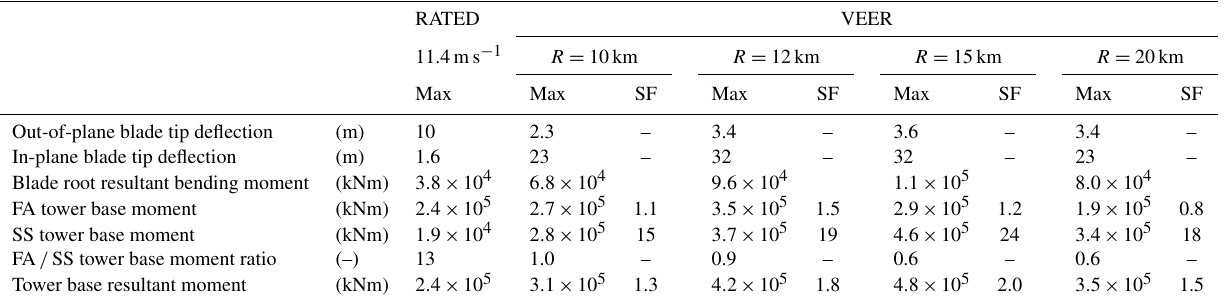
Table 5. Maxima of blade and tower structural response to the VEER case. The scale factor (SF) indicates the magnitude of response relative to RATED. Cells highlighted in gray indicate values that exceed the Eurocode strength basis value for the tower (5 . 4 × 10 5 kNm) or the 18m deflection limit on the blade tip. Numerical values of the scale factors are not provided when not appropriate (for blade deflections the blade is oriented differently in the rated case, and the scaling of FA / SS tower base moment ratios is not a meaningful measure of response).